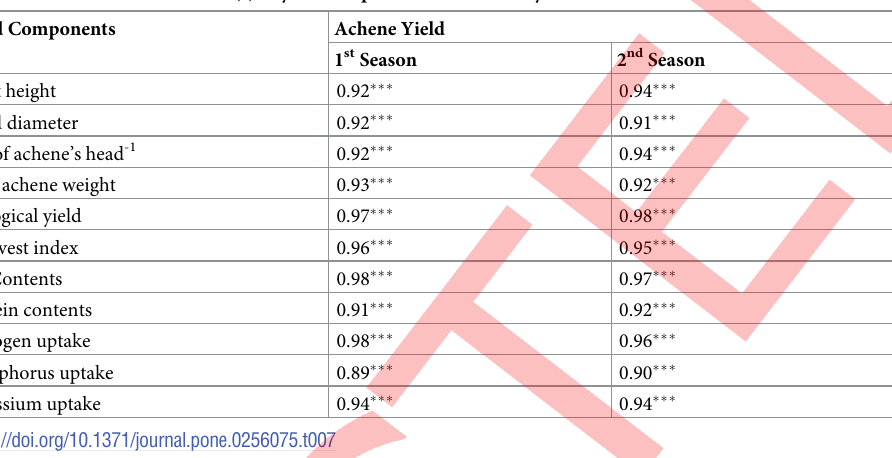
Table 7. Correlations coefficient (r) of yield components with achene